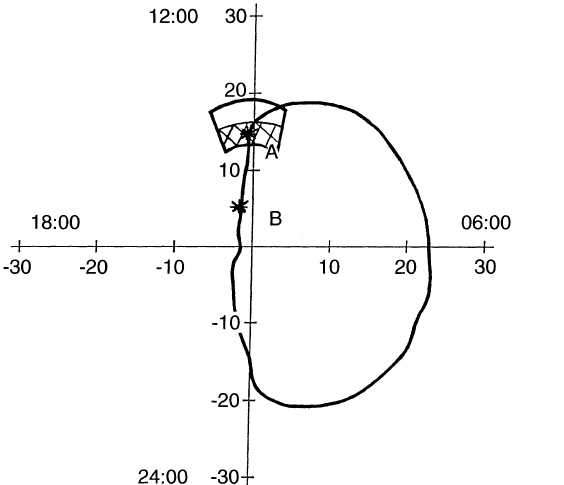
Fig. 4. Model NO (cid:135) , O (cid:135) and N (cid:135) ion concentrations during the 2 2 enhanced velocity event at 9:23 UT (- - -), point A on path, and at 9:53 UT (– –), point B on the path. Concentrations with no enhanced velocity are shown for comparison